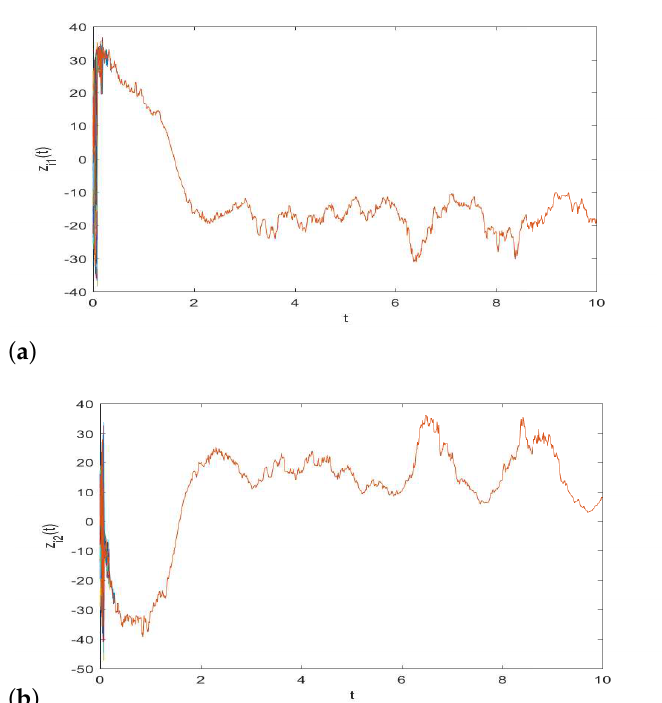
Figure 2. Time evolution of z i ( t ) in multi-link complex networks (40) under the hybrid impulsive